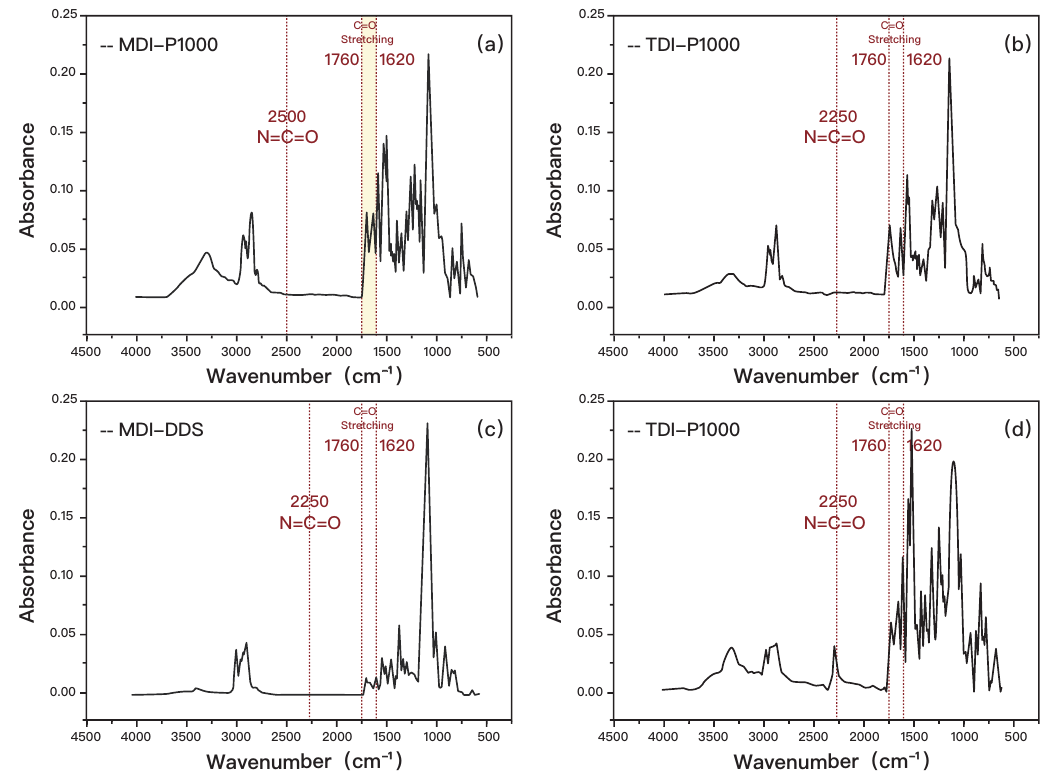
Figure 1. FTIR spectra of ( a ) TDI-P1000, ( b ) MDI-P1000, ( c ) MDI-D2000, and ( d )